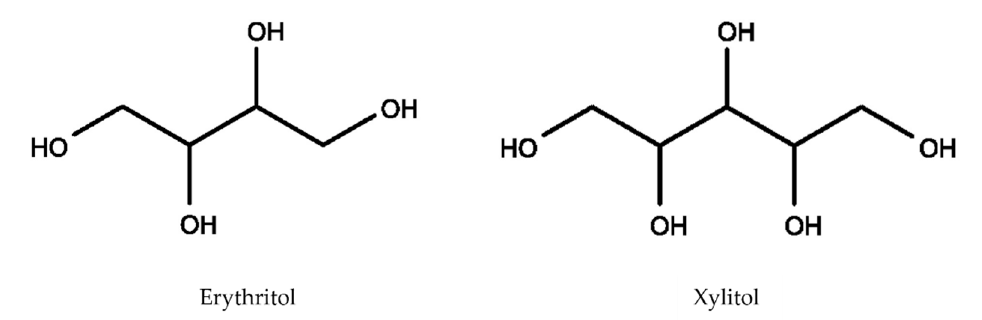
Figure 1. Chemical structures of erythritol and